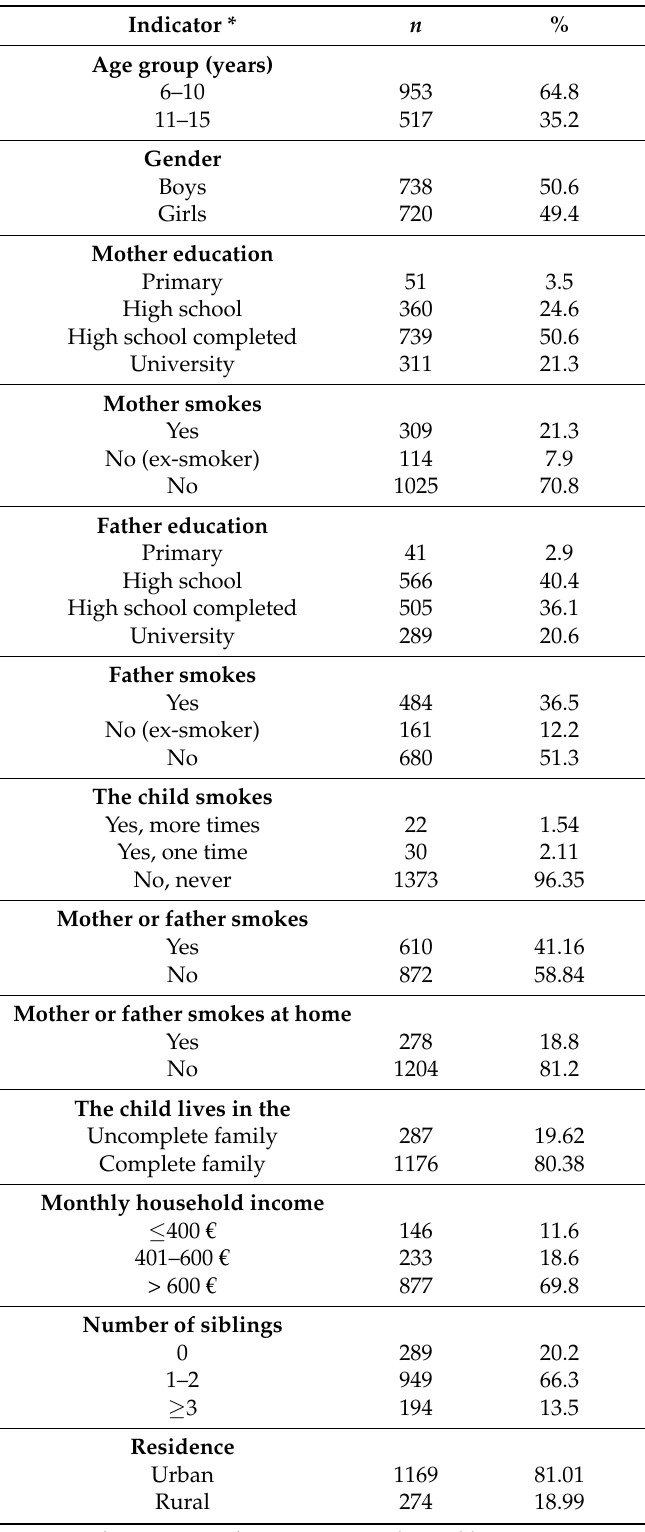
Table 1. Characteristics of the sample of Slovak children ( n =